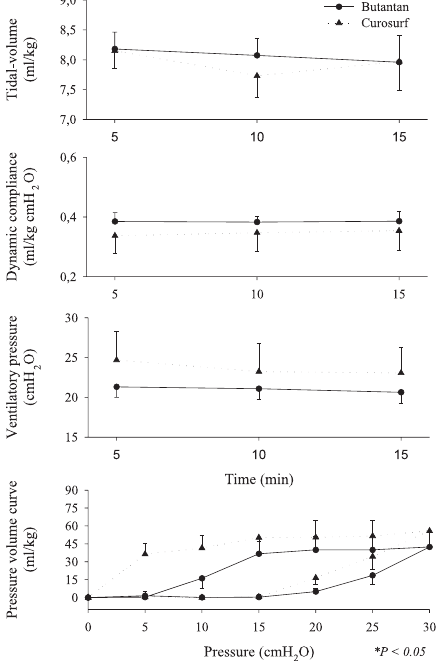
Figure 5 - Time point 3 (60 days after being kept at 20 o C-water bath temperature before being warmed to 37 o C for 5 minutes) data for tidal- volume (V ), dynamic compliance (DC), ventilatory pressure (VP), and t pressure-volume curve (mean ± SD). Data were analyzed by the Student t test (parametric data) or Mann-Whitney test (nonparametric data).